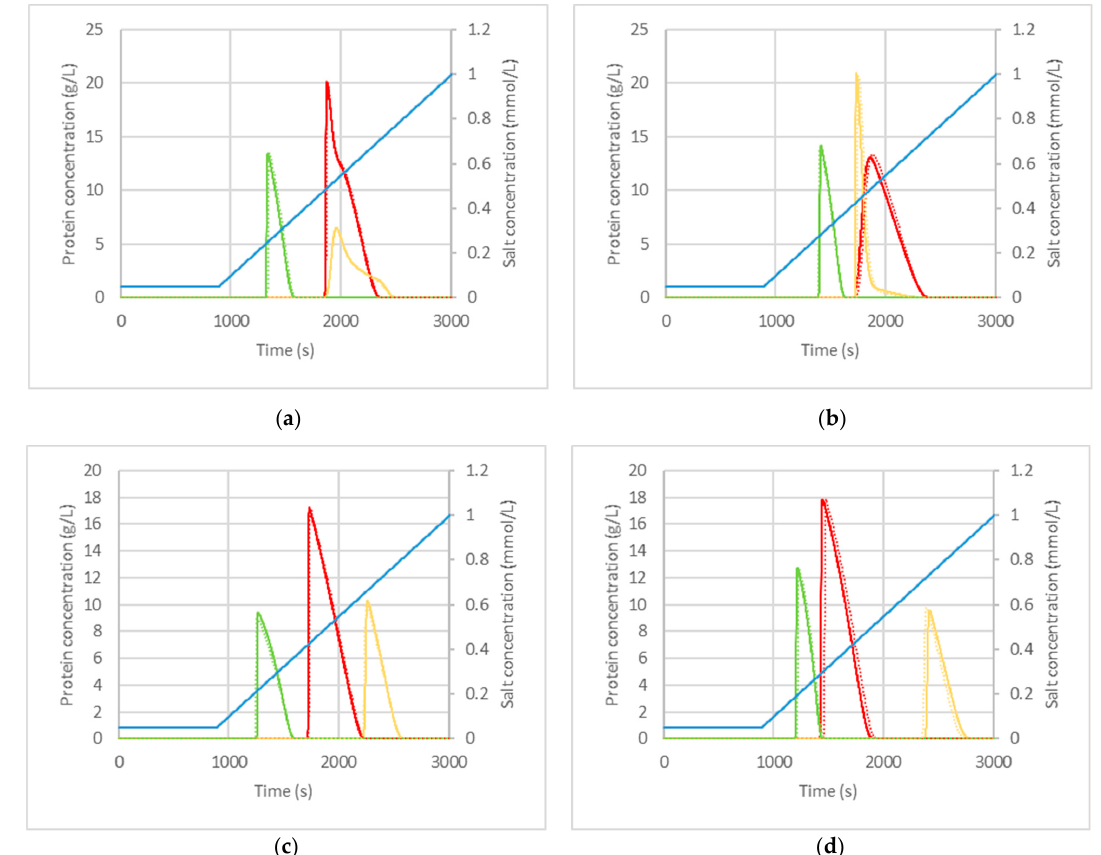
Figure 5. Comparison of four chromatograms with original and ANN-predicted isotherm parameters from the validation set. In all subplots, the protein group HCP1 is green, the protein group HCP2 is yellow, and the IgG is red. Solid lines represent the chromatograms original isotherm parameters. Dashed lines represent the chromatograms with ANN-predicted isotherm parameters: ( a ) Depicts strongly overlapping peaks with nearly maximum loading of IgG and HCP2, and strongly non-ideal Gauss-peaks with clear competitive behaviour. ( b ) Illustrates similar behavior like ( a ) with peak switching. ( c ) and ( d ) show the typical “shark-fin” shape of highly loaded columns with baseline separation.